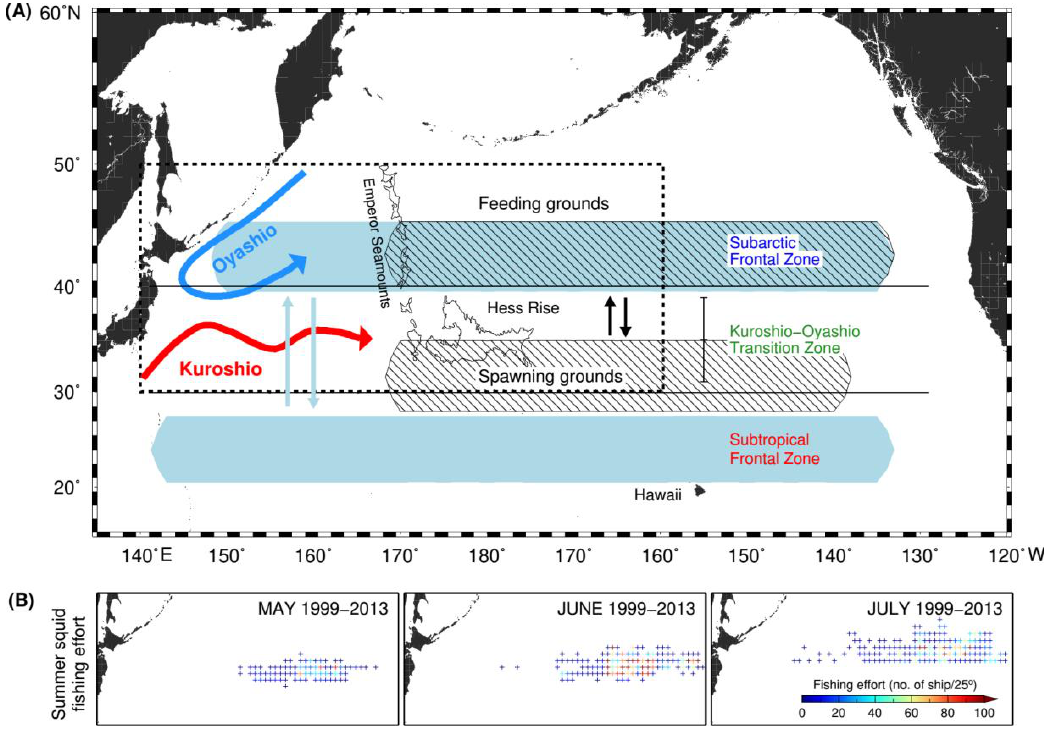
Figure 1. ( A ) Map of the North Pacific, showing the study area enclosed by the dotted box. Further highlighted are the major oceanographic (currents and frontal zones) and topographic features, along with the putative geographical extents of the annual migration between the spawning and foraging grounds for the autumn cohort of the neon flying squid [7]. ( B ) Spatial distributions of Japanese squid fishing effort (expressed as the total number of fishing vessel per 0.25° geographic grid) in summers between May and July 1999–2013.